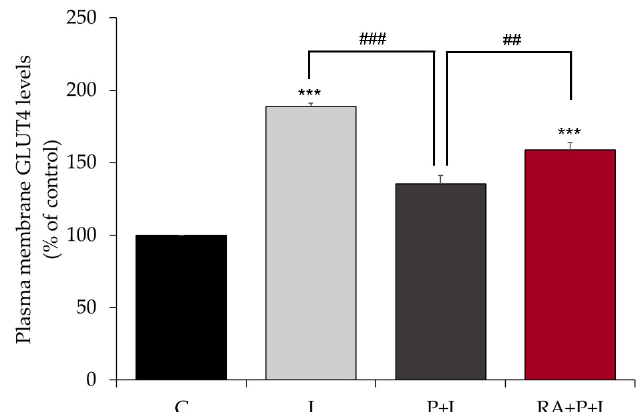
Figure 3. Rosmarinic acid abolishes the deleterious effects of palmitate on insulin ‐ stimulated GLUT4 translocation. GLUT4myc overexpressing L6 myotubes were treated without (control, C) or with 0.2